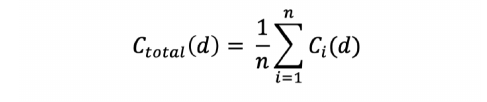
Figure 5. Average compliance of all groups for each version on a specific day.